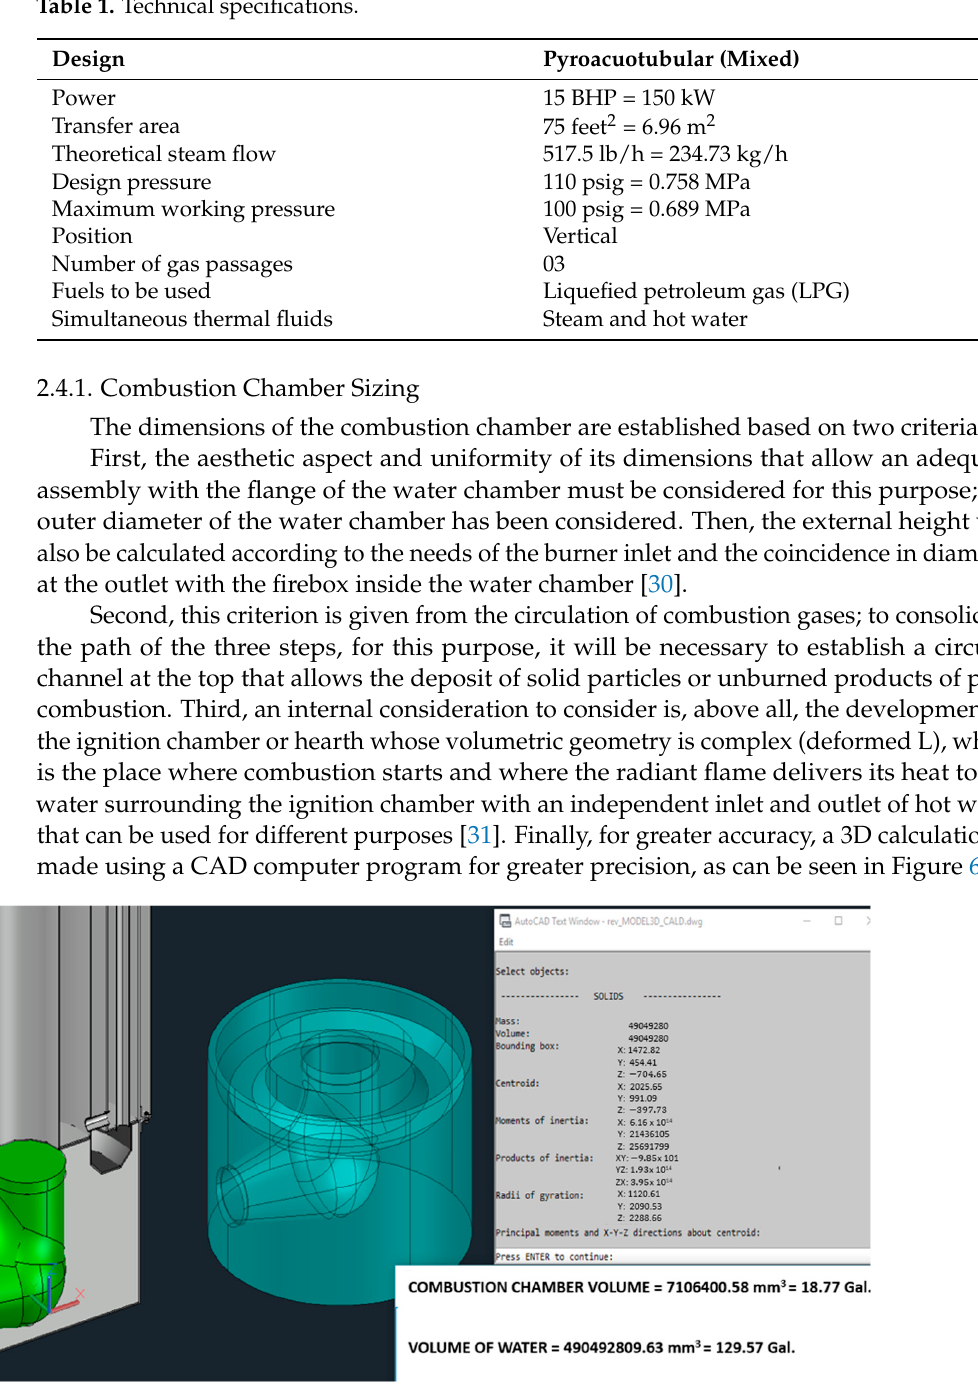
Figure 6. Firebox inside the 3D combustion chamber.